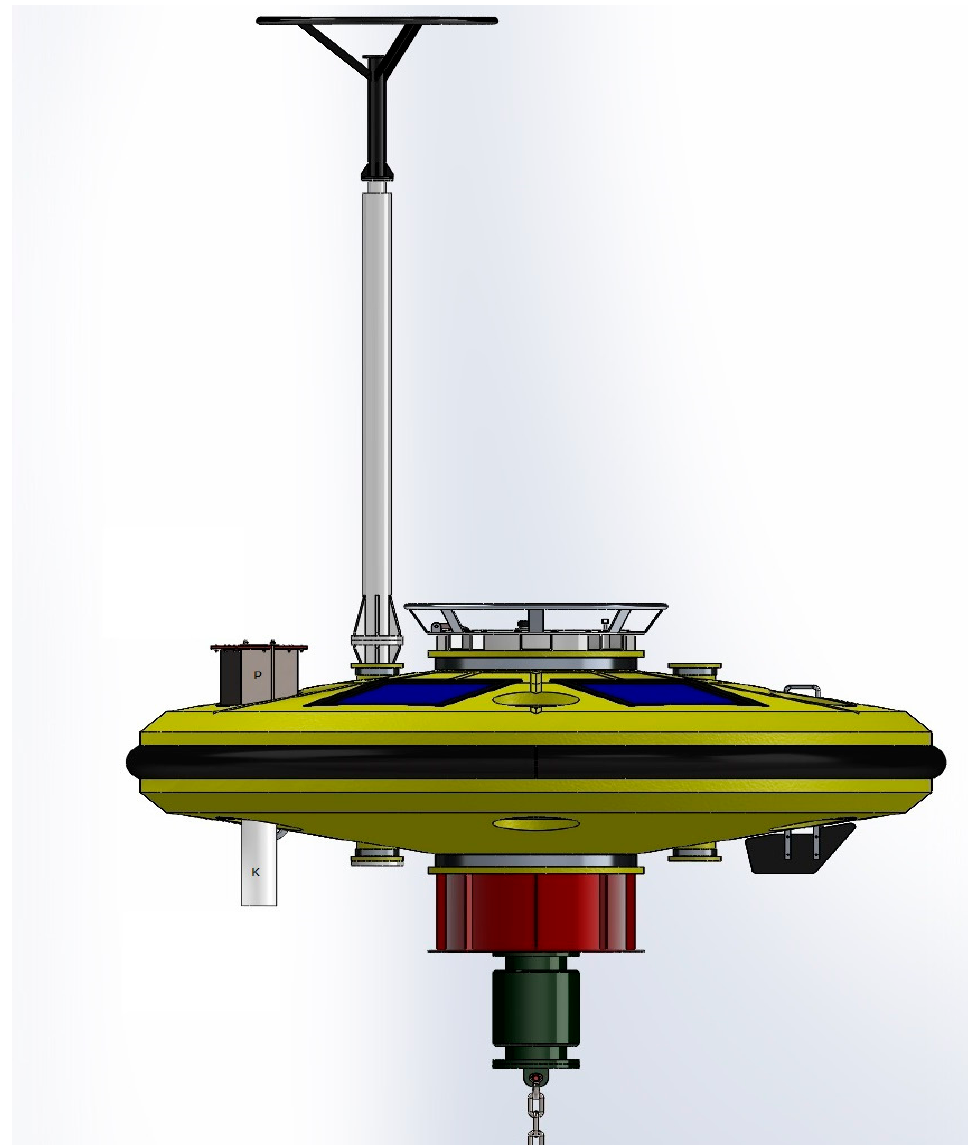
Figure 2. The POSEIDON fixed station at Athos (North Aegean Sea). The sensor is represented with “K” and the power supply unit with “P”.